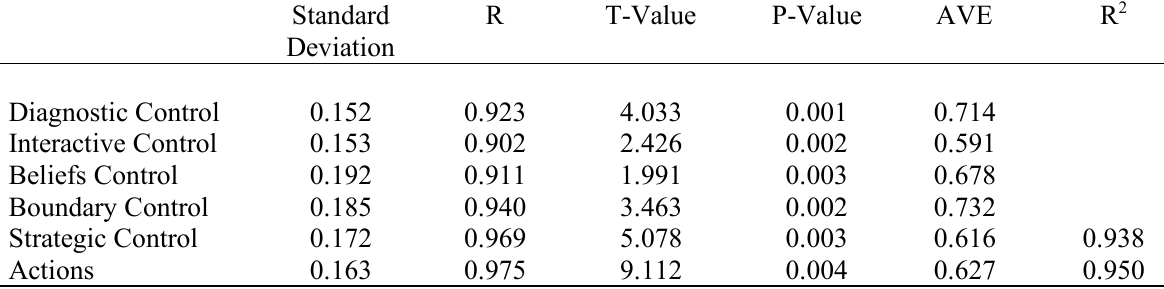
Table 4 . Summary of Hypotheses Testing Hypotheses